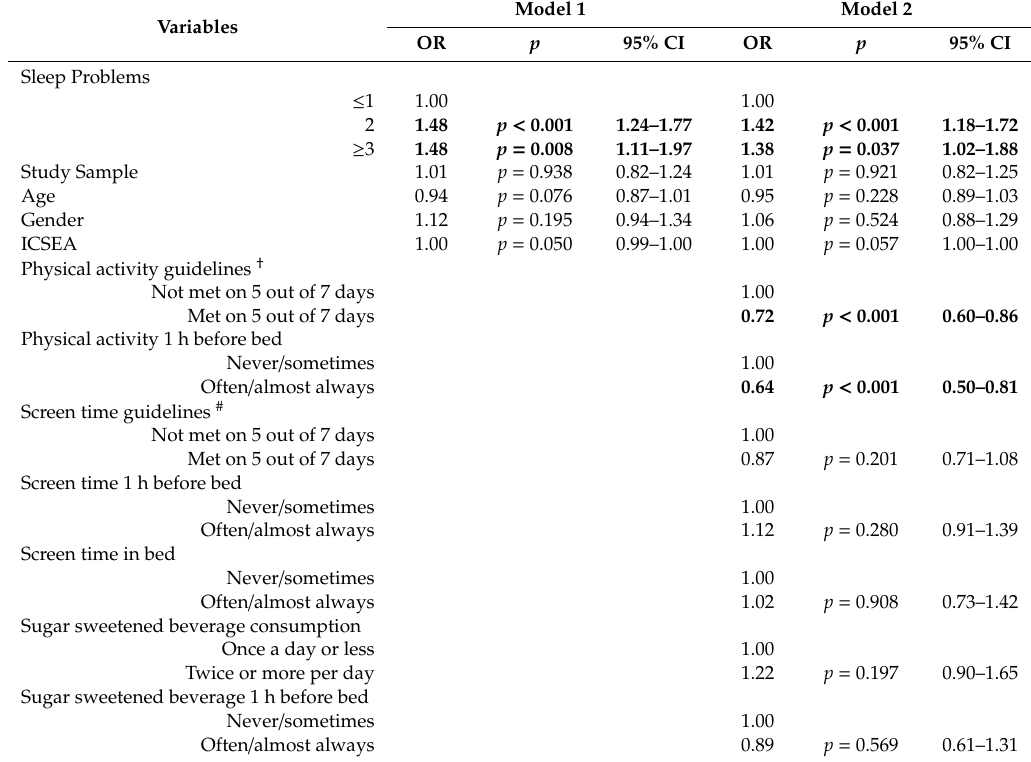
Table 4. Unadjusted and adjusted logistic regression with odds ratio (OR) for overweight / obesity with sleep score and behavioral